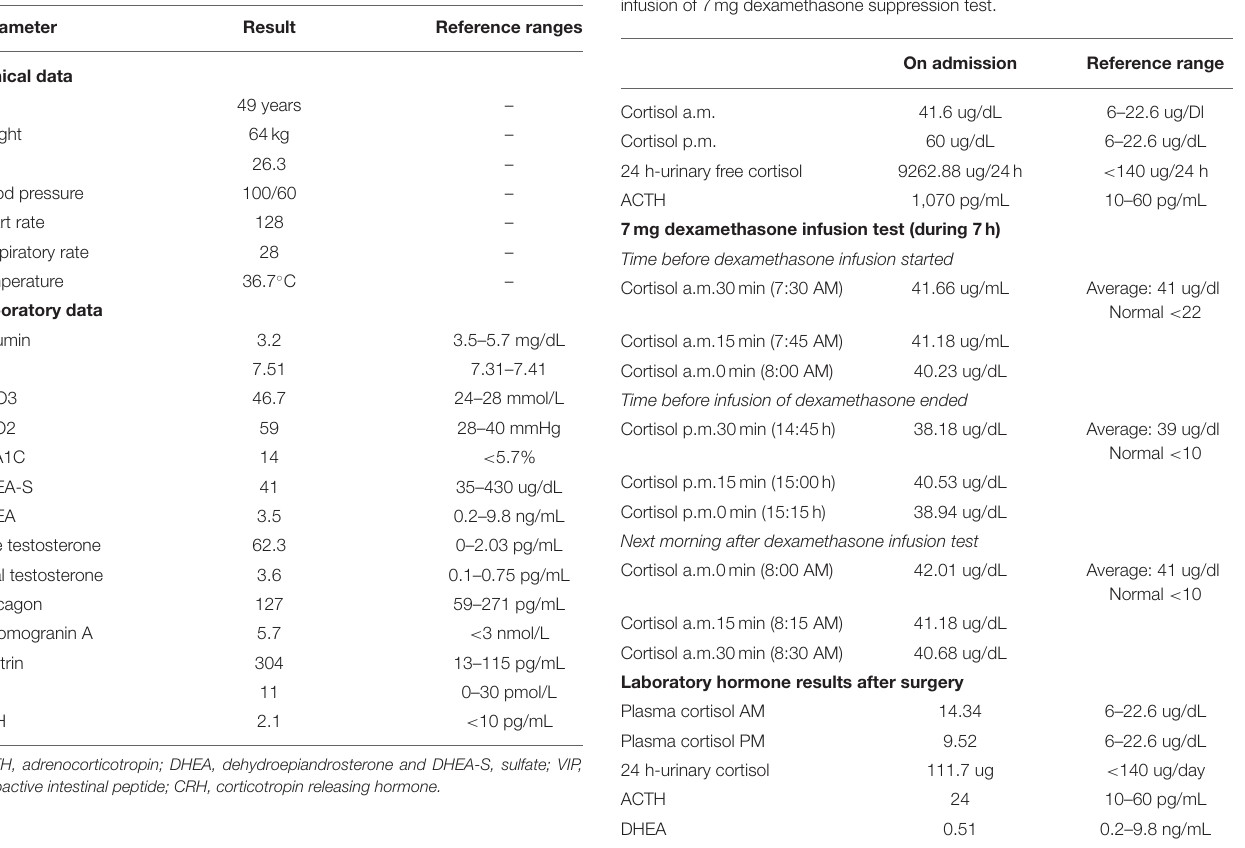
TABLE 1 | Clinical and laboratory data at diagnosis. TABLE 2 | Baseline cortisol and ACTH values and results of continuous 7h IV